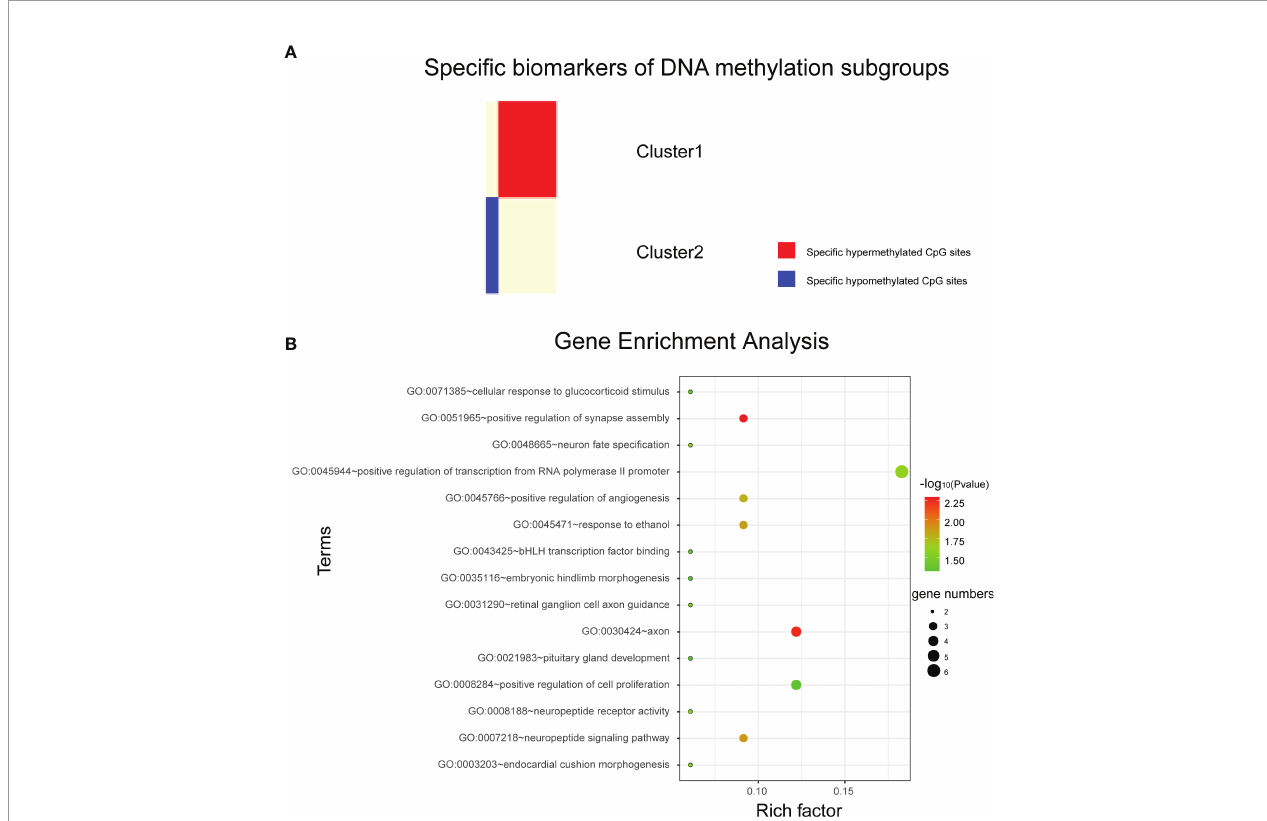
FIGURE 3 | Analysis of subtype speci fi c biomarkers. (A) Speci fi c hyper/hypo methylated CpG sites for DNA methylation cluster1 and cluster2. (B) Gene enrichment analysis of genes corresponding to speci fi c hypermethylated CpG sites in